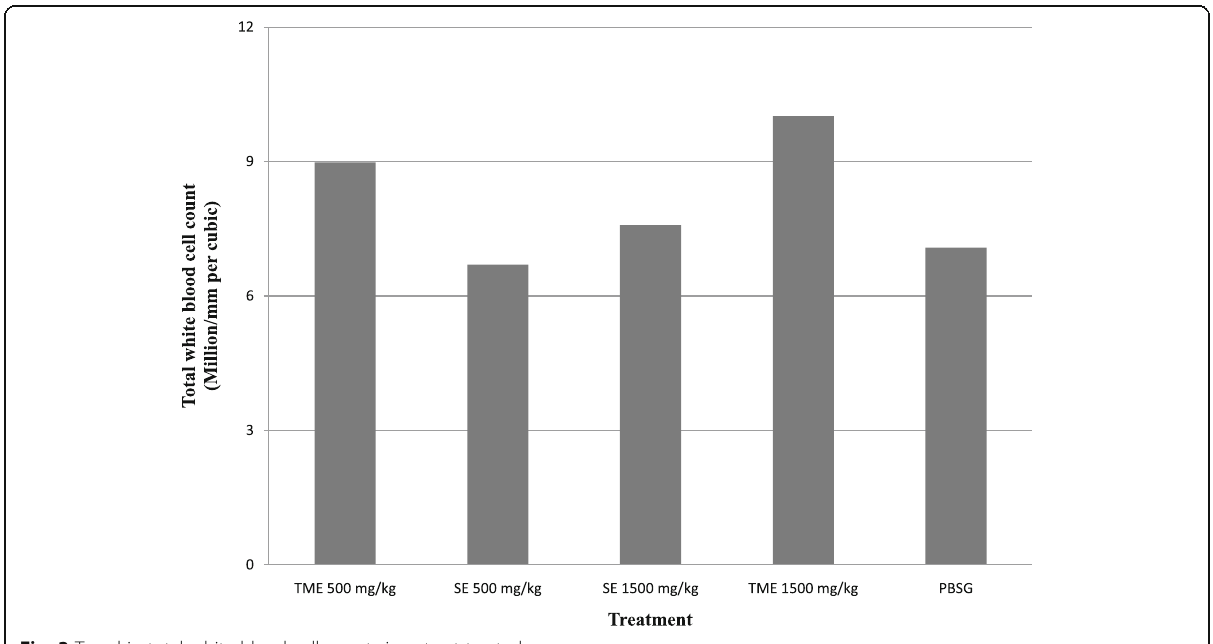
Fig. 3 Trend in total white blood cell counts in extract treated groups